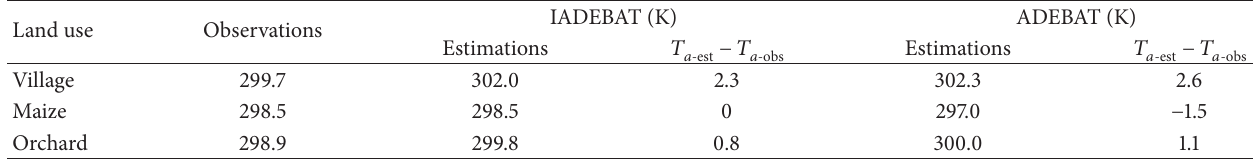
Table 2: Air temperatures measured by meteorological stations and retrieved by the IADEBAT and the ADEBAT models from three different land use types on June 24th, 2012.